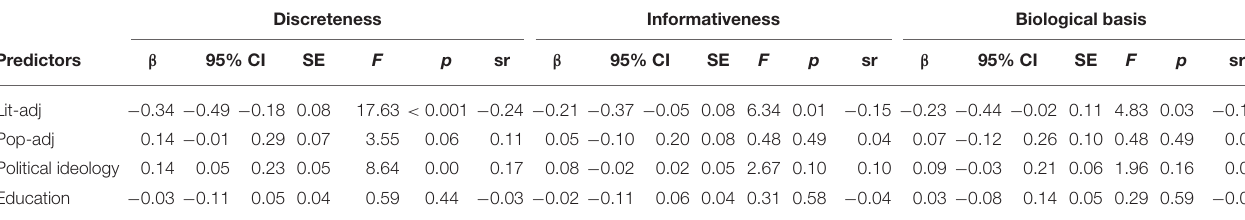
TABLE 4 | Multiple regression results (Study 2).